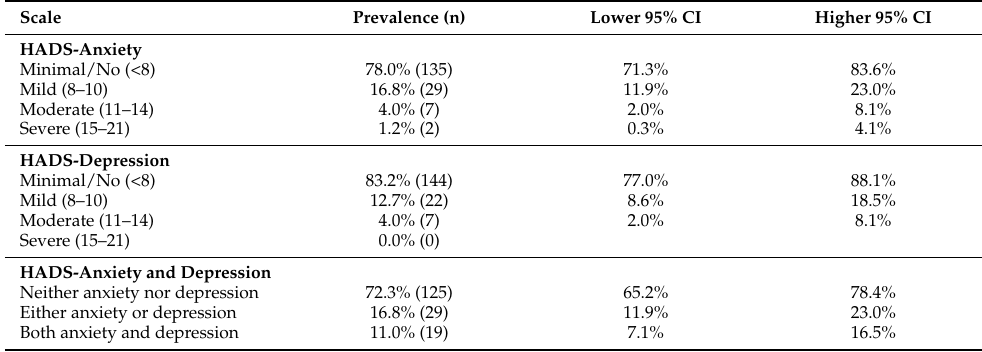
Table 2. Prevalence of anxiety and depression symptoms among psychiatric healthcare workers at University Malaya Medical Centre (n = 173).